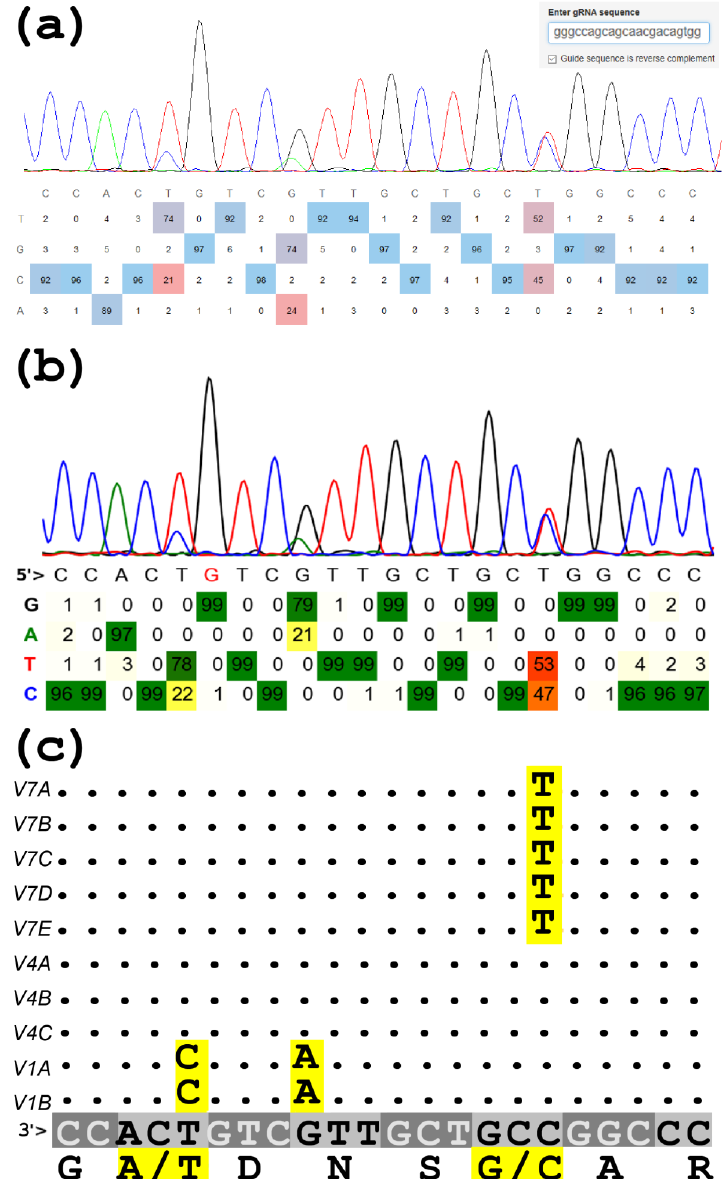
Figure 1. An example of estimating gene copy-number proportions based on sequence chromatograms of the third exon of bovine gene CD32 . ( a ) Application of EditR, an R program for base-editing quantification [27]. ( b ) Application of BEAT, a Python program for base-editing quantification [30]. ( c ) An allele model based on DNA-sequencing that follows a previously published Figure 4 [40] but in the reverse orientation. Dots indicate similarity to the consensus sequence of 10 allele variants predicted by the assembled sequences and counts of this sire’s DNA-Seq reads. Putative amino acid translation is given below the consensus sequence, in which codons are annotated by alternating font and background color. Nucleotide and amino acid variations are highlighted in yellow. The presented trace file was obtained from sequence analysis using BigDye terminators kit 3.1 (Thermo Fisher Scientific, Waltham, MA, USA) run on an ABI3730 Automated Sequencer; and analyzed by Sequencing Analysis Software 5.3.1 with KB Basecaller